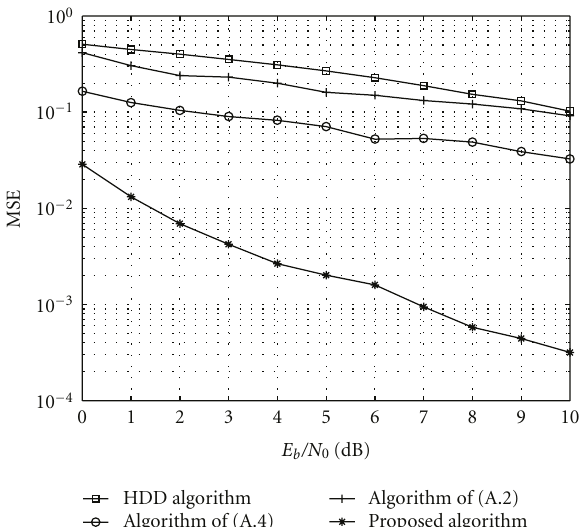
Figure 7: MSE of the phase o ff set estimation for a